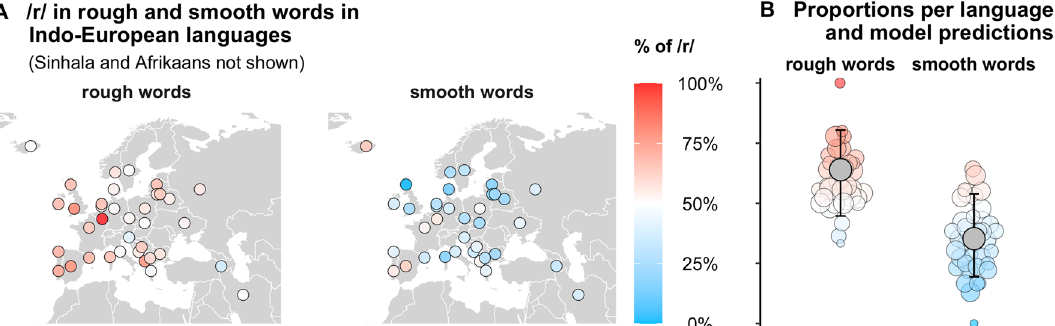
Figure 4. ( A ) Across the Indo-European language family, the proportion of rough words with /r/ is much higher than the proportion of smooth words with /r/; ( B ) Each dot represents a language (size of the circle = number of words); whiskers show 95% Bayesian credible intervals corresponding to the mixed-effects Bayesian logistic regression analysis indicating that rough words have a much higher proportion of /r/ (posterior mean = 63%) than smooth words (posterior mean =